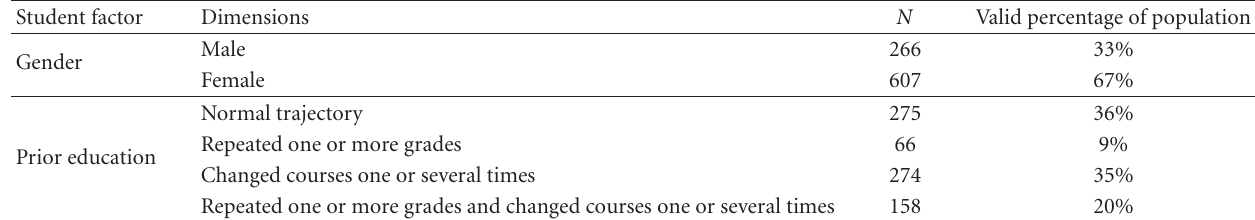
Table 3: Distribution of background